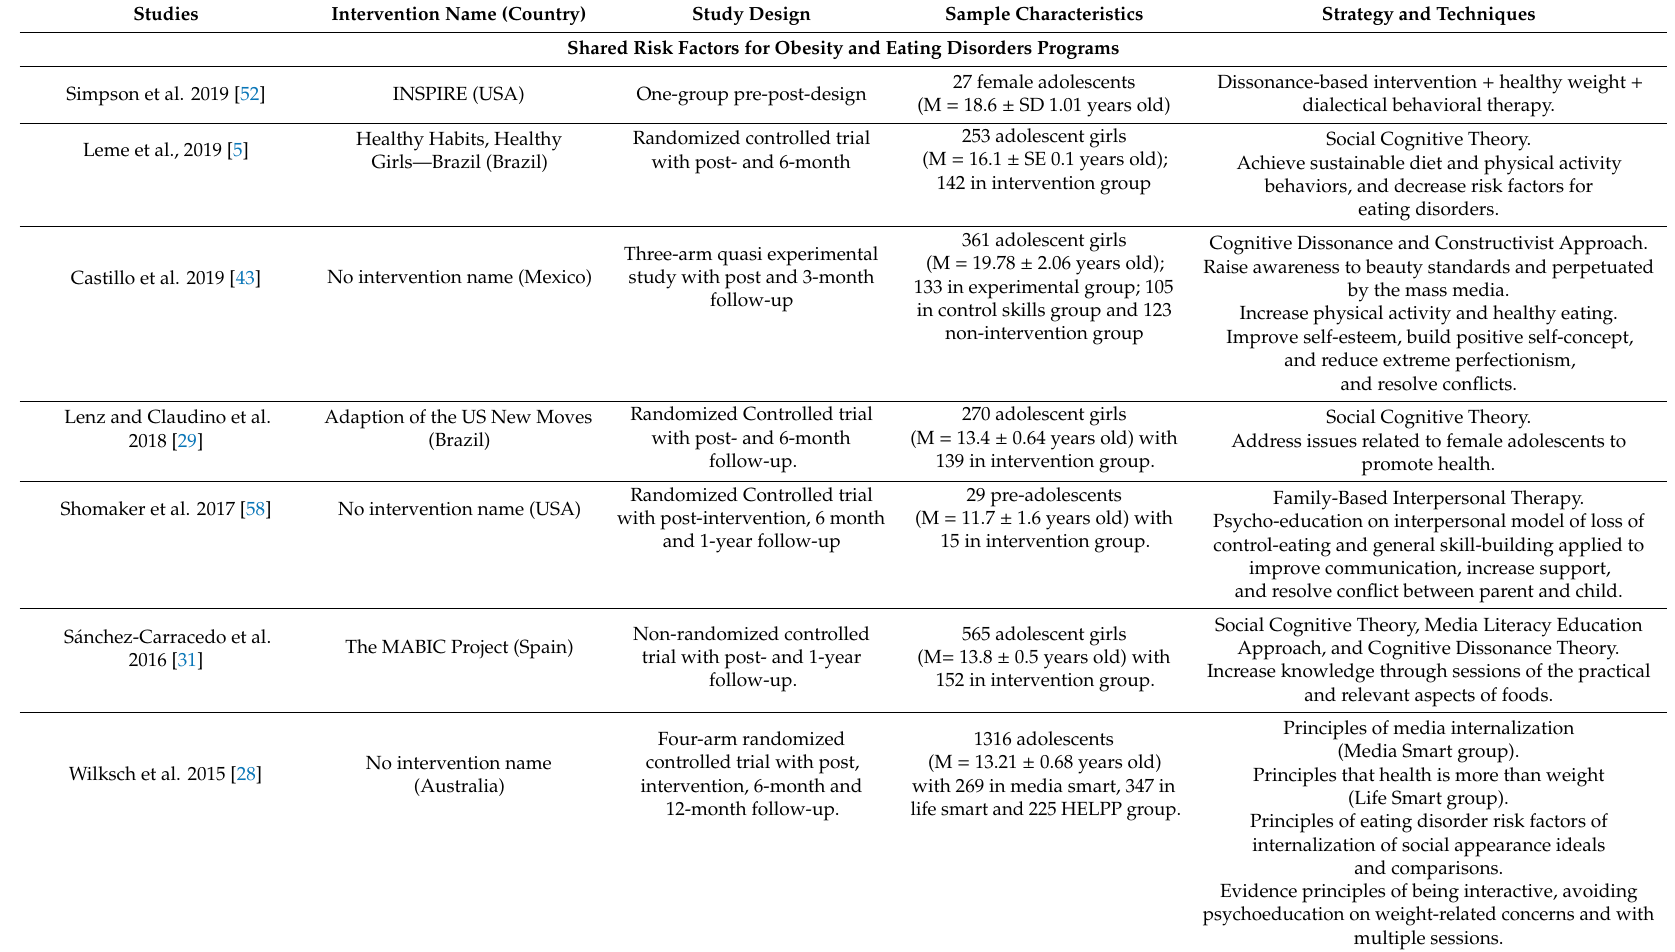
Table 1. Characteristics of the included studies, assessments, and outcomes of the intervention